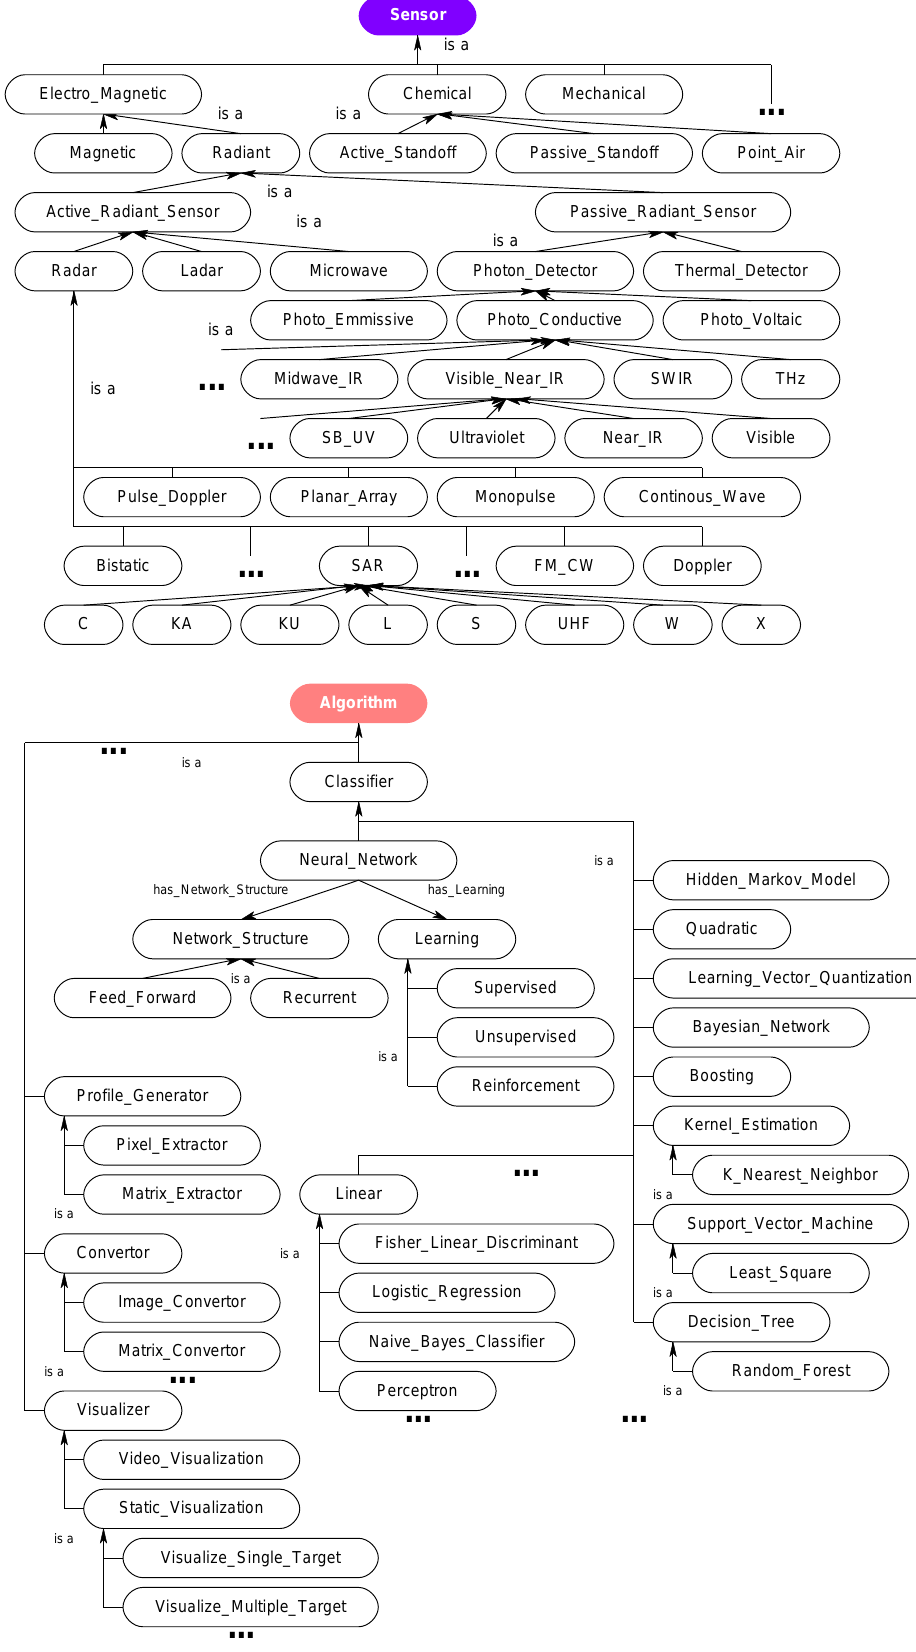
Figure 11. Extended class hierarchy of the ontological problem-solving framework for the Sensor and Algorithm